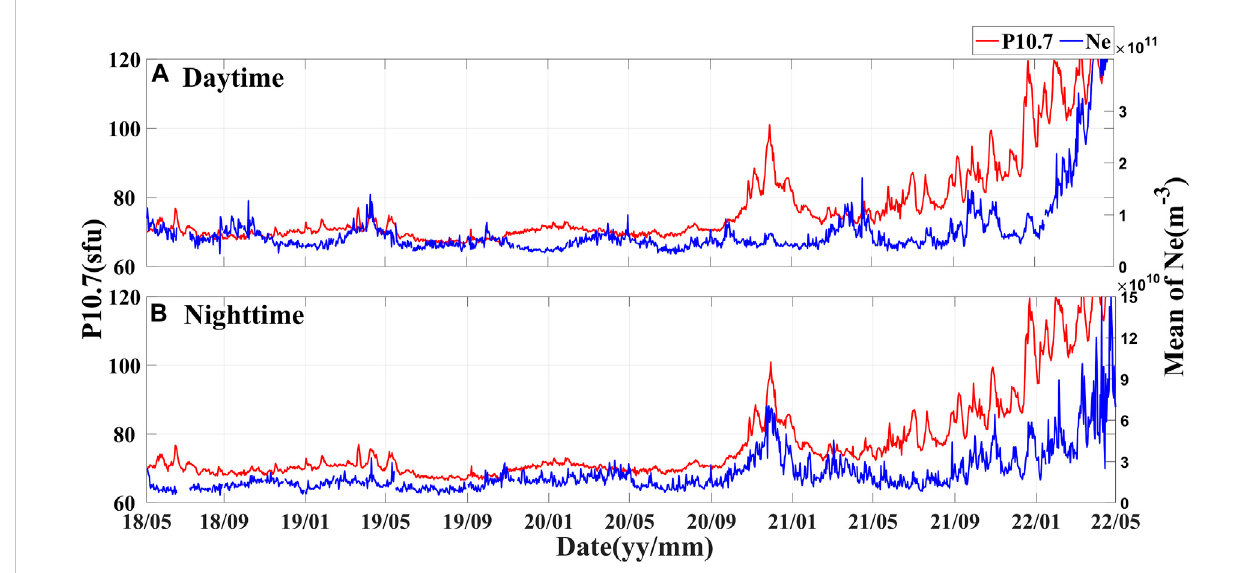
FIGURE 1 Time series of solar activity index P10.7 and Ne in the daytime (A) , nighttime (B) , the red line represents P10.7, and the blue line represents Ne